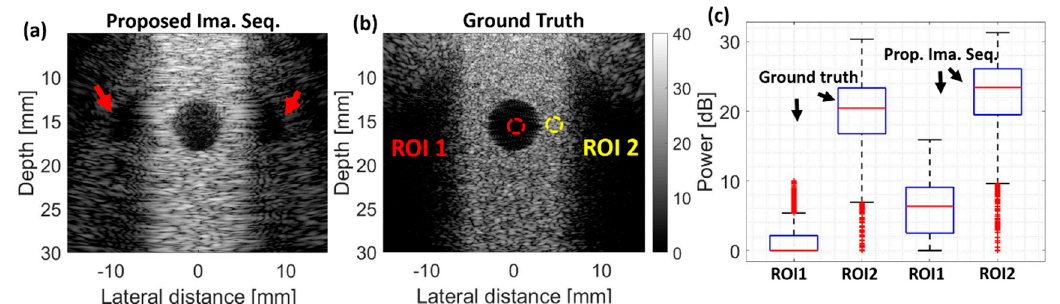
Figure 9. The reconstructed images using ( a ) the proposed imaging sequence (full-aperture transmission, Nr = 5 and Ns = 3) and ( b ) the CBC imaging sequence (GT). ( c ) Statistical analysis of the image intensities indicated by two regions of interest (ROI1 and ROI2) which are the red and yellow circles, respectively.